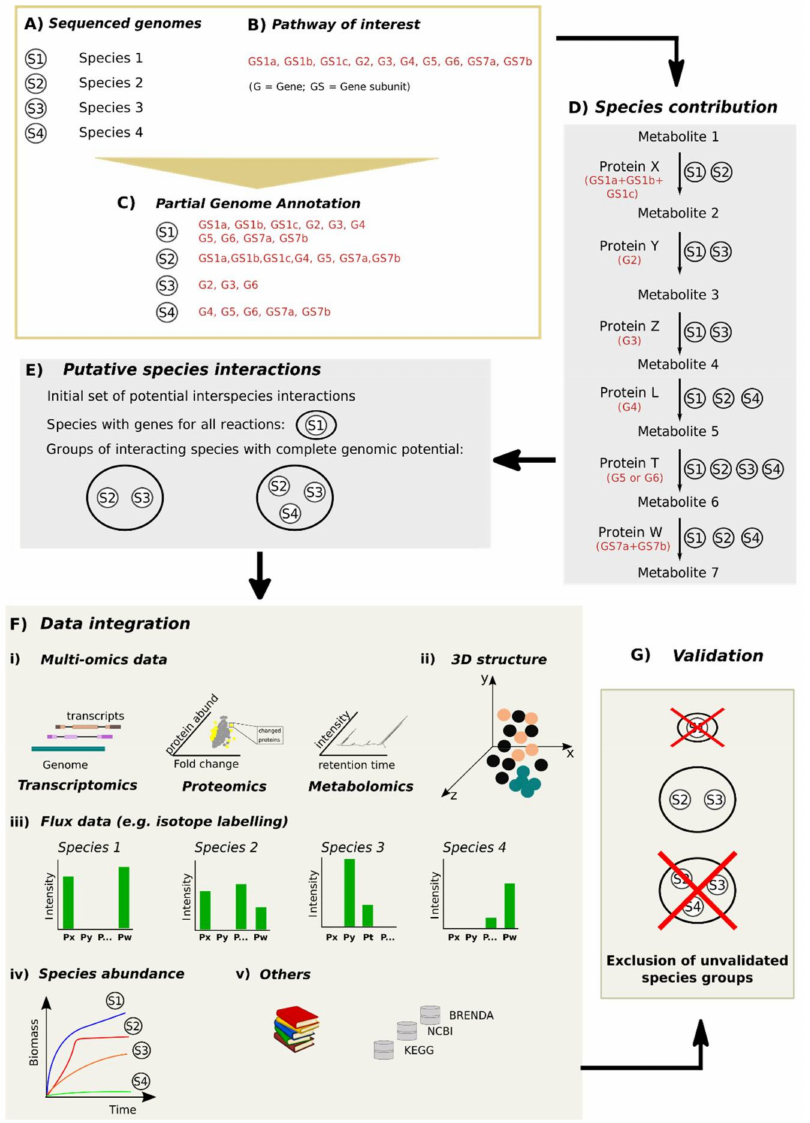
Figure 2. Theoretical work frame for prediction of interspecies interactions. Here, a microbial community is composed of four species ( A ) and a hypothetical ecosystem process/pathway of interest ( B ) requires the presence of five single protein-encoding genes and five protein-encoding genes that participate in the formation of two protein complexes. First, annotation of individual genomes from the microbial community is performed using only the set of target genes ( C ). From here, one can determine which species possess the complete functional potential to perform the target pathway ( D ). Additionally, one can also determine which species or groups of species possess a combined genomic potential to perform the complete ecosystem process ( E ) putative interacting species. Further refinement of the generated lists can be achieved by the inclusion of experimental data, species absolute abundances, literature searches, specialized databases and other omics data types (e.g., transcriptomics, metabolomics and proteomics) ( F ) leading to increased robustness of predictions and reduction of the number of interspecies interactions for experimental validation ( G